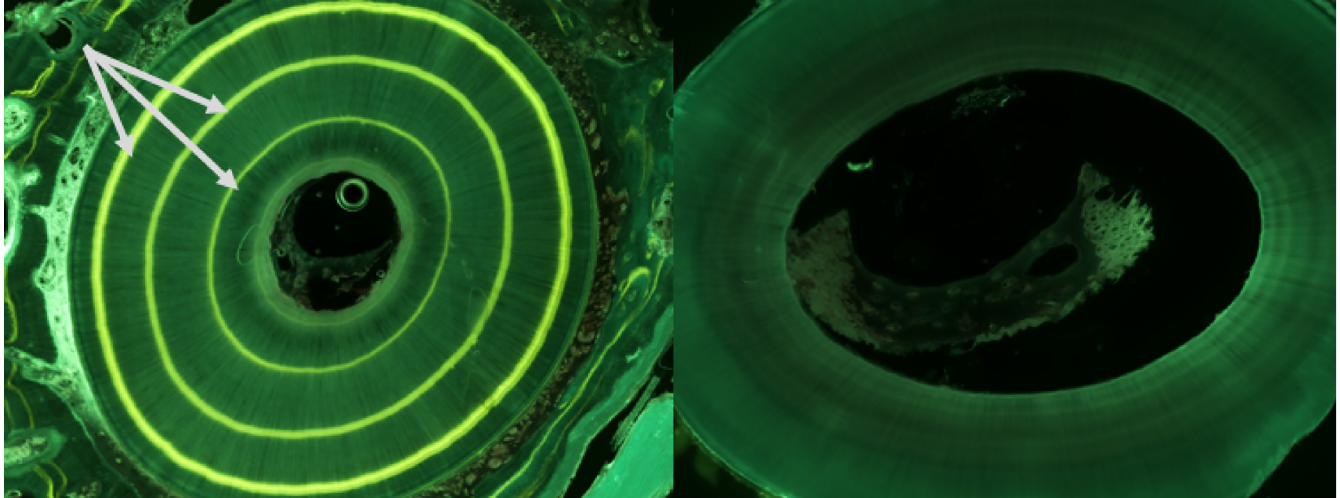
Fig 2. Tooth root apex from mink with tetracycline (TC)(left) and without TC (right) . Thin slices (70–100 μ m) of the tooth root apex from mink under a microscope, left photo from a mink treated at least three times with tetracycline (TC) and right photo from an untreated mink. TC can be seen as bright yellow bands in the tooth cementum